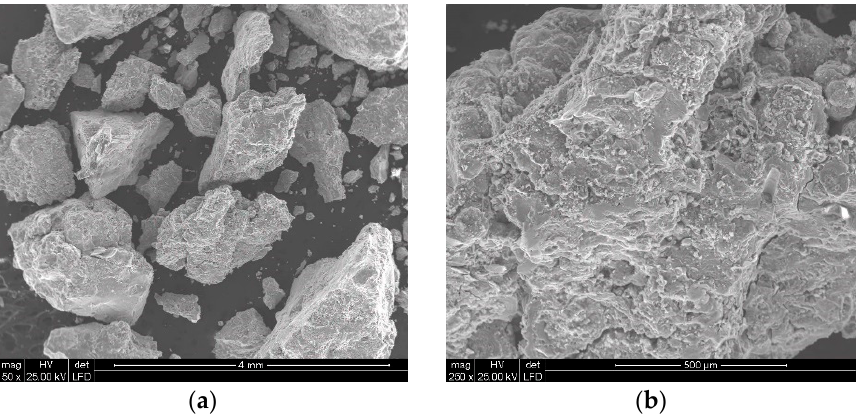
Figure 6. Example SEM images of polymetallic nodule particles ( a ), along with a view of their surface development ( b ), crushed in a jaw crusher.